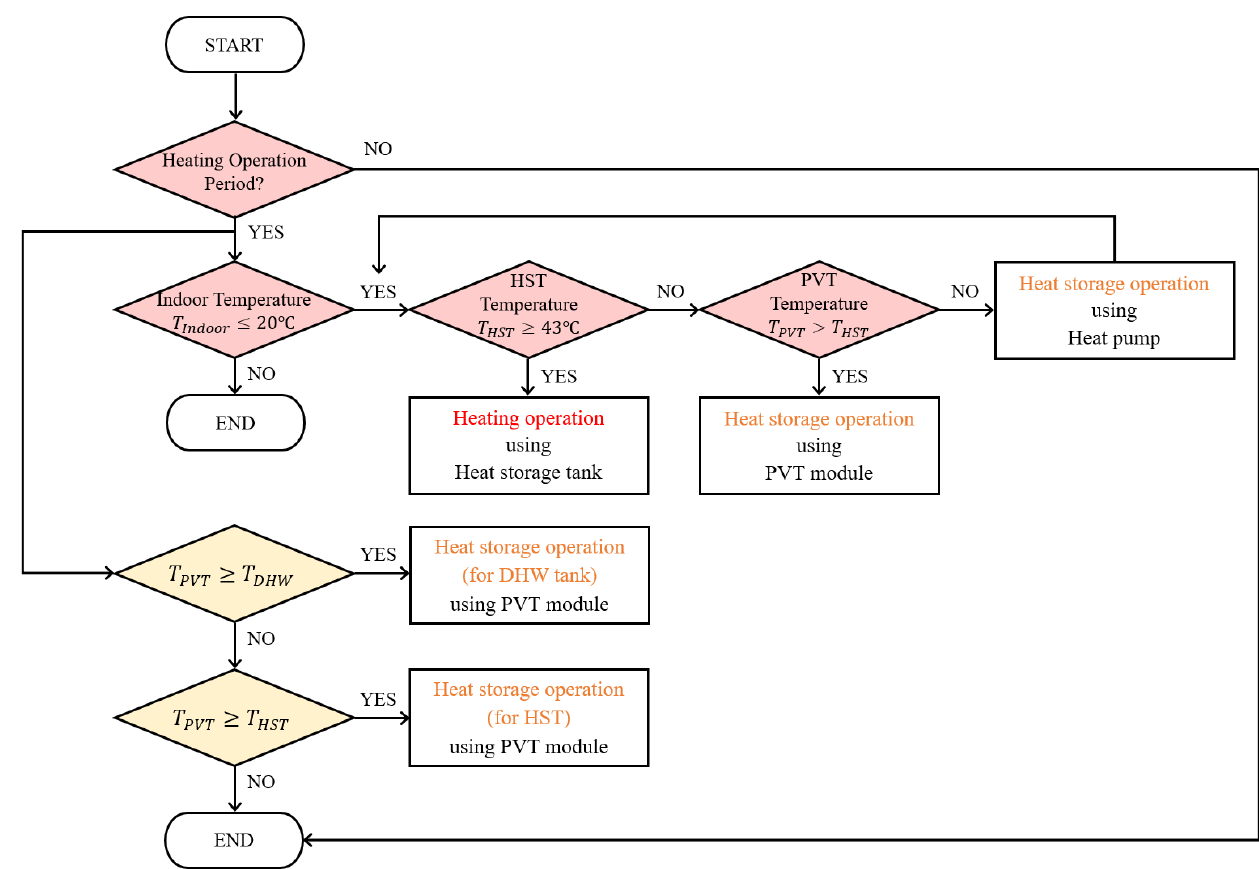
Figure 2. Operation strategies during the heating season.